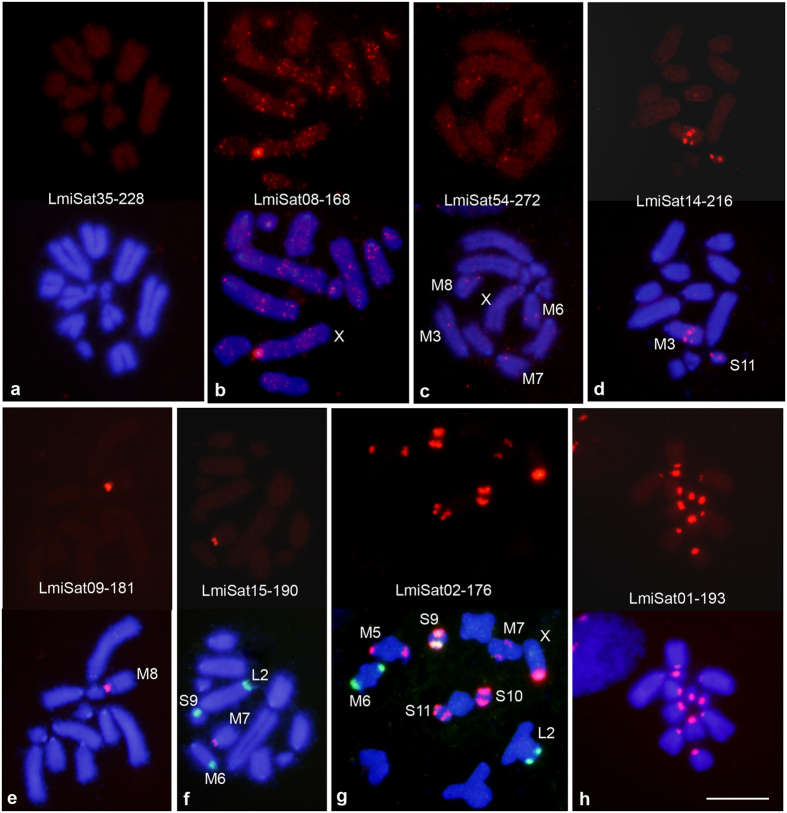
Physical mapping of eight of the long satDNAs found in Locusta migratoria, showing the three patterns of chromosome distribution observed: non-clustered (a), clustered (d–h) and mixed (b–c). All cells showed here (except that in (g)) are mitotic metaphase haploid cells from haplo-diploid embryos obtained in our laboratory. The cell in (g) is at meiotic metaphase I and was obtained from an adult male. Each cell is shown in red color for satDNA FISH (upper panel) and merged with DAPI (lower panel). In (f,g), double FISH was performed to distinguish whether the sat-carrying chromosome was M6 (harboring rDNA shown in green) or any other medium-sized chromosome. Note in (h) the presence of LmiSat01–193 in the pericentromeric regions of all chromosomes.